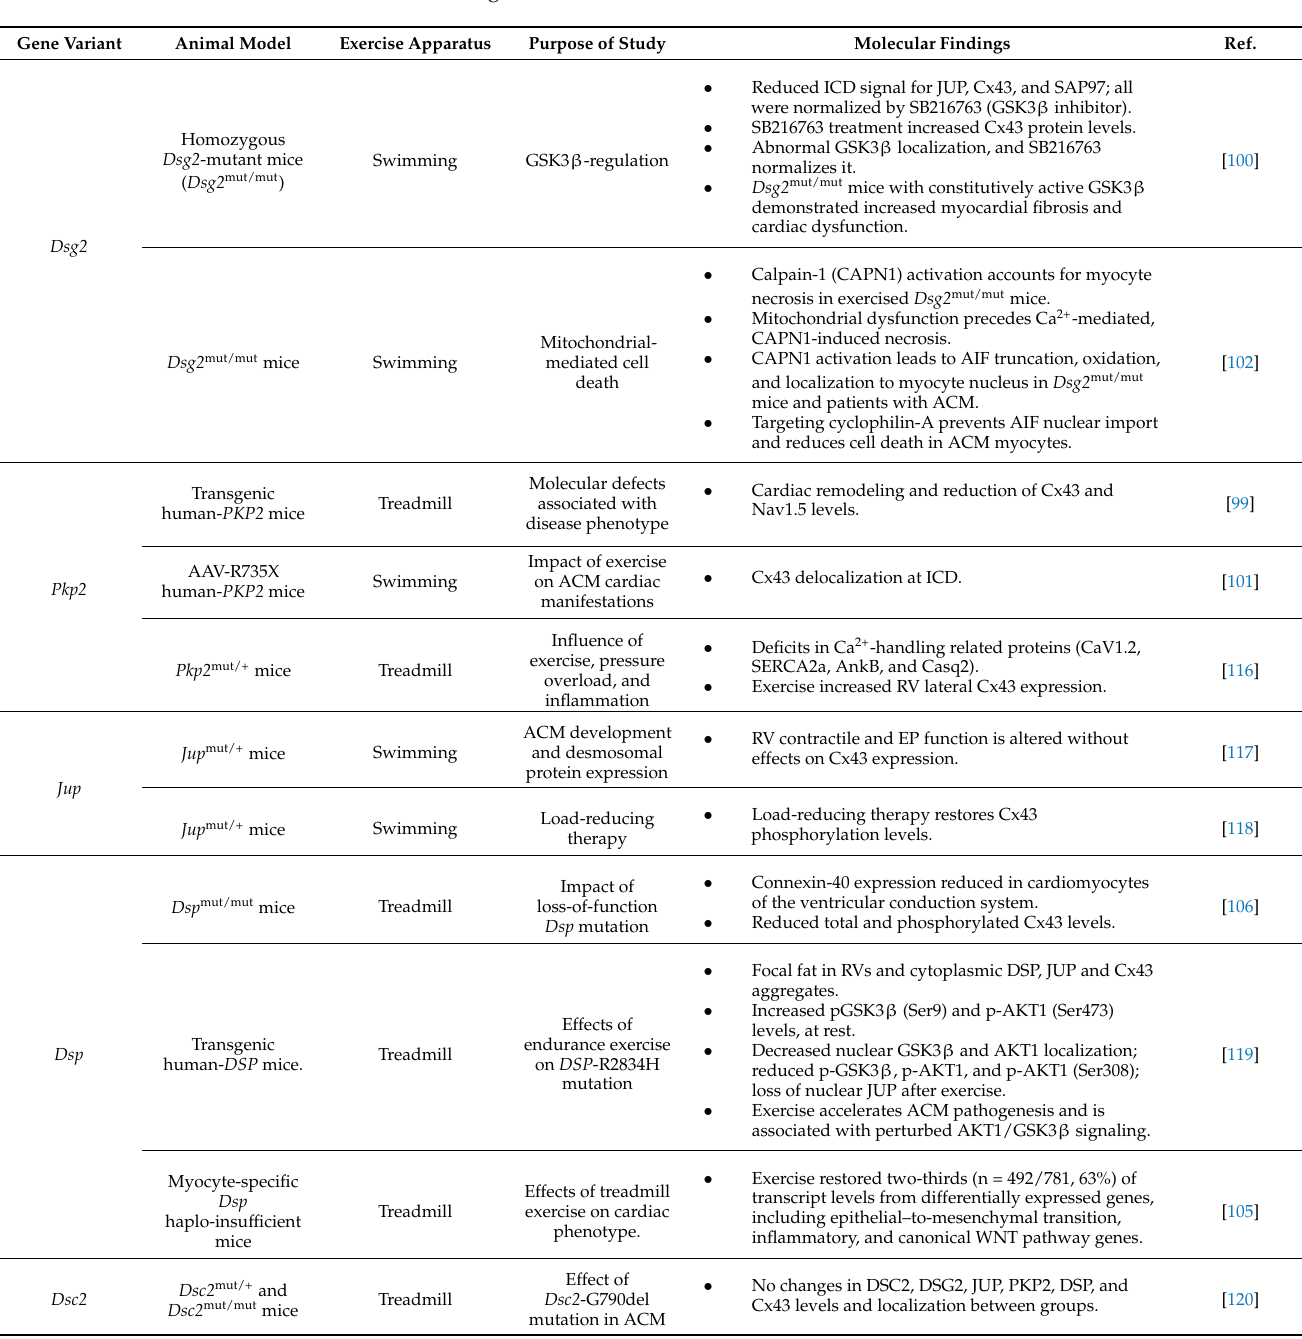
Table 1. Summary of contemporaneous studies on exercised ACM murine models and their respective molecular